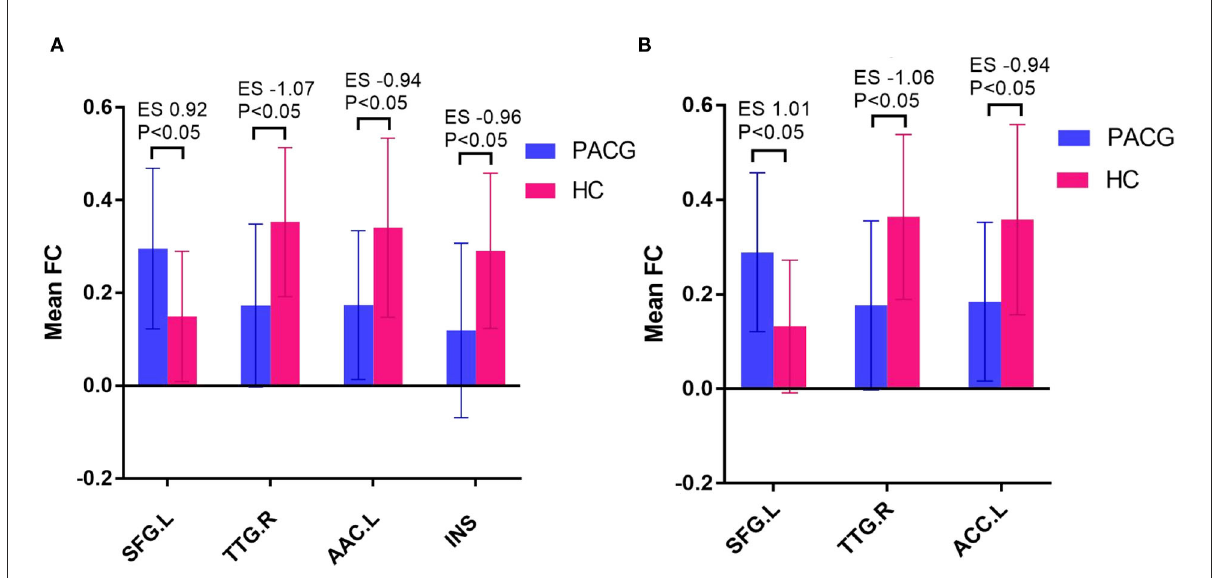
FIGURE4 Mean weighted FC values of HCs and PACG patients in altered regional brain areas based on the left thalamus seed (A) .and right thalamus seed (B) . FC, functional connectivity; PACG, primary angle-closure glaucoma; HCs, healthy controls; TTG, transverse temporal gyrus; ACC, anterior cingulate cortex; INS, insula; SFG, superior frontal gyrus; ES, effect size; L, Left; R, Right.